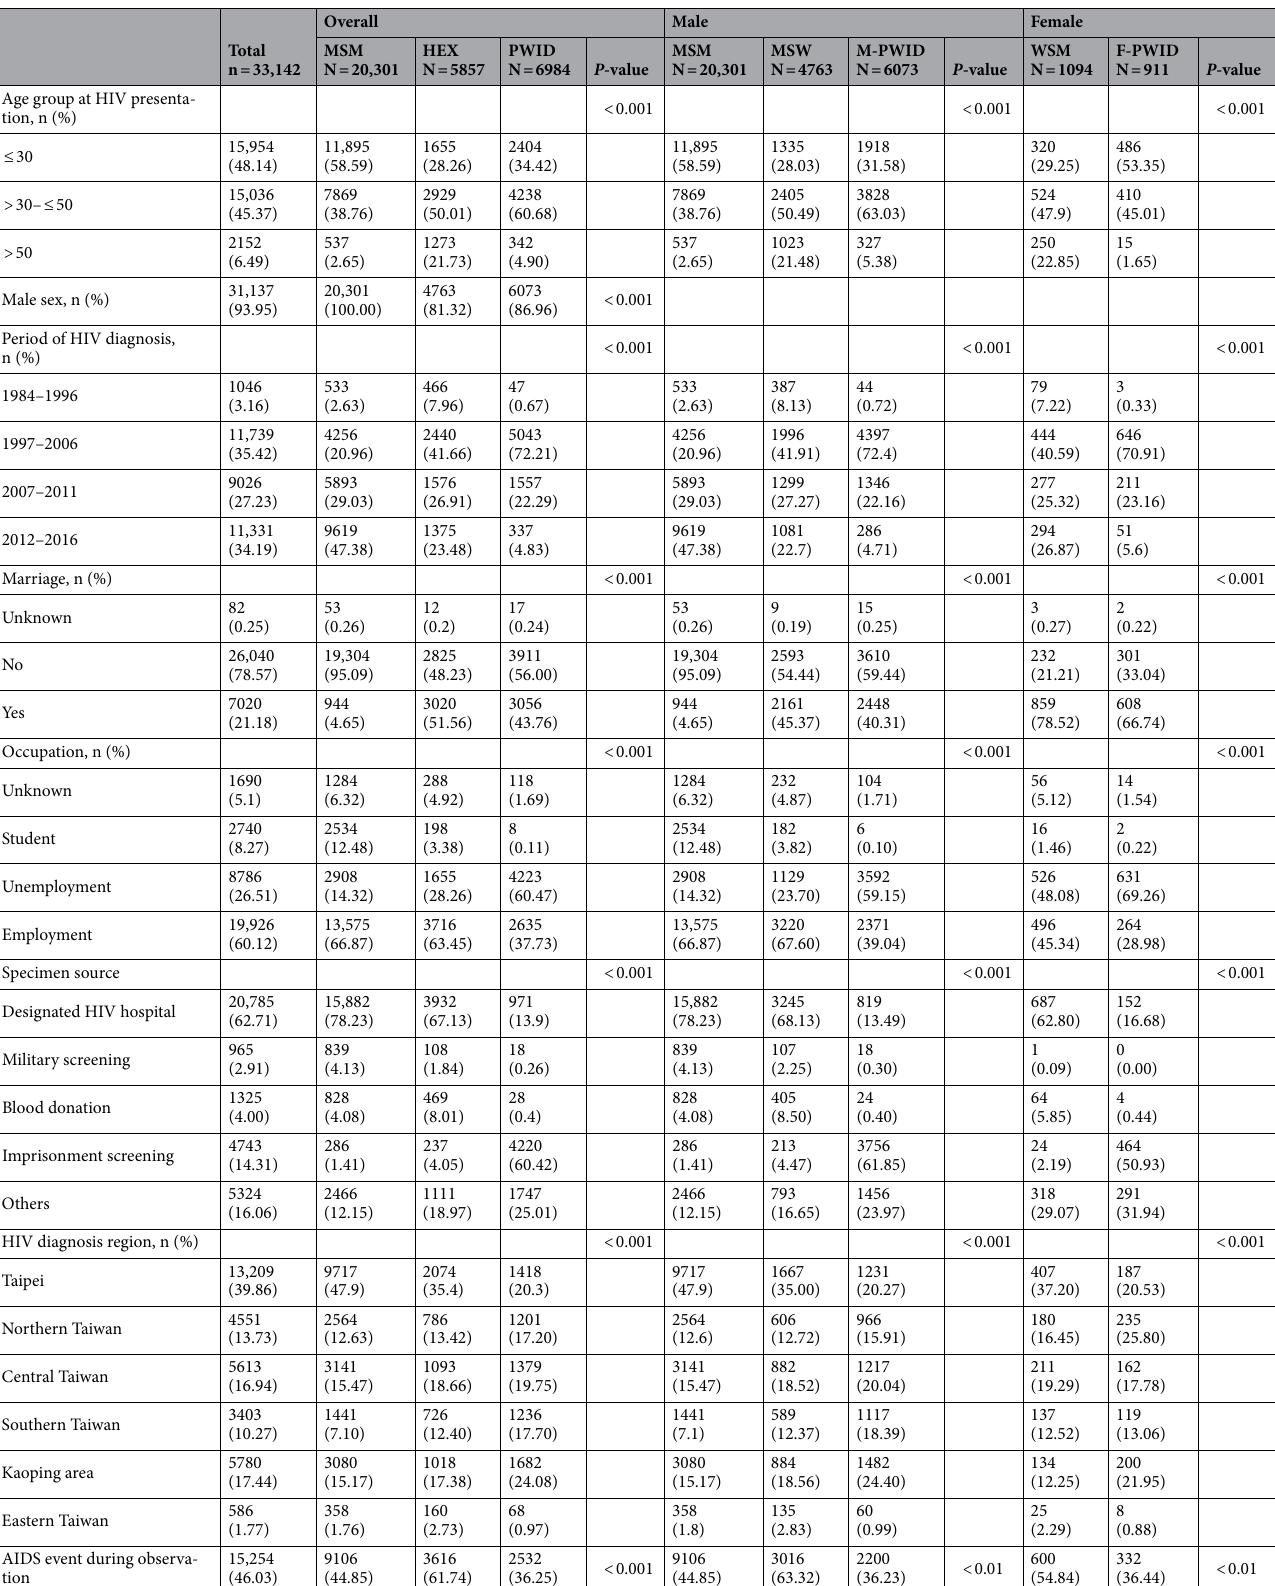
Table 1. Comparison of sociodemographic characteristics of enrolled people across key populations, overall and within each sex. Abbreviation: AIDS, acquired immunodeficiency syndrome; HEX, heterosexual;